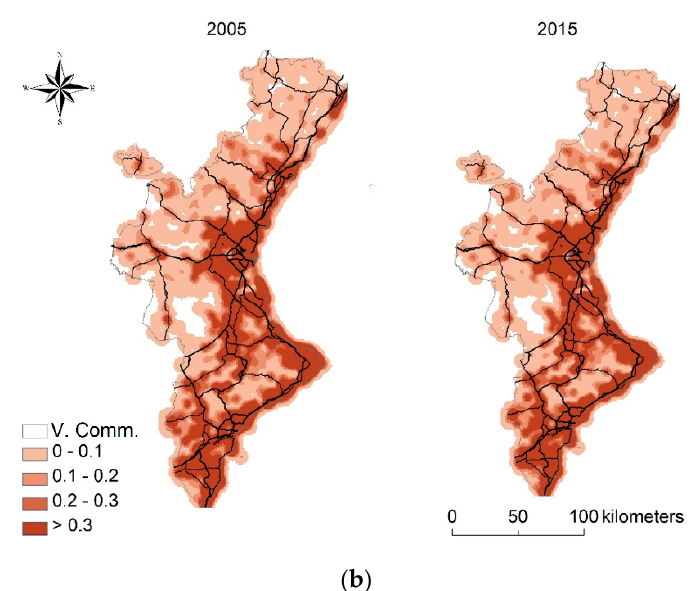
Figure 4. Kernel analysis of ( a ) industrial and ( b ) residential land-use polygon centroids in 2005 and 2015, based on main roads.